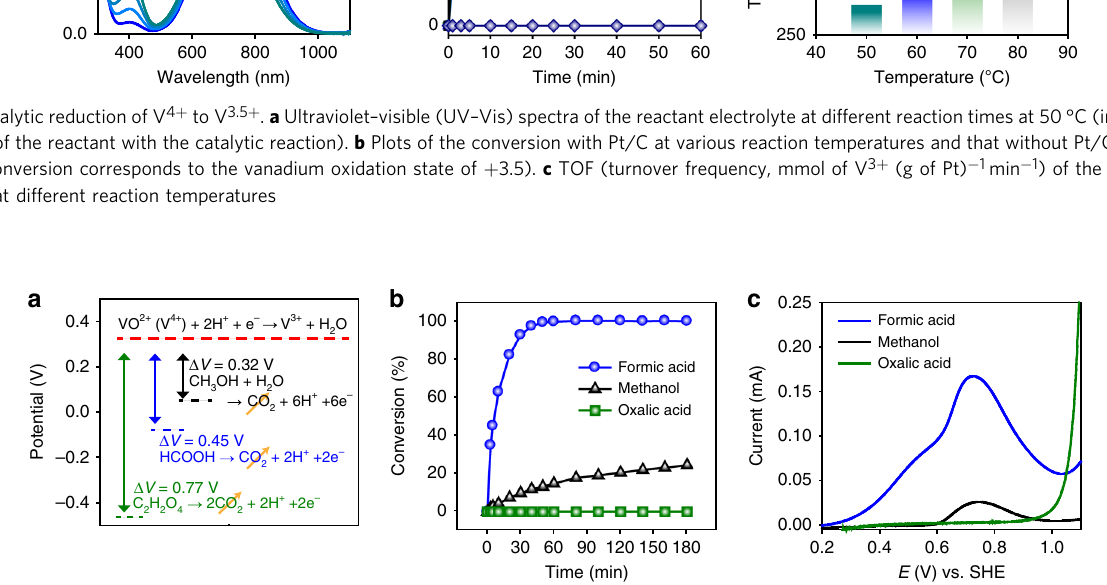
using formic acid and a typical fuel cell catalyst, Pt nanoparticles supported on carbon black (Pt/C).